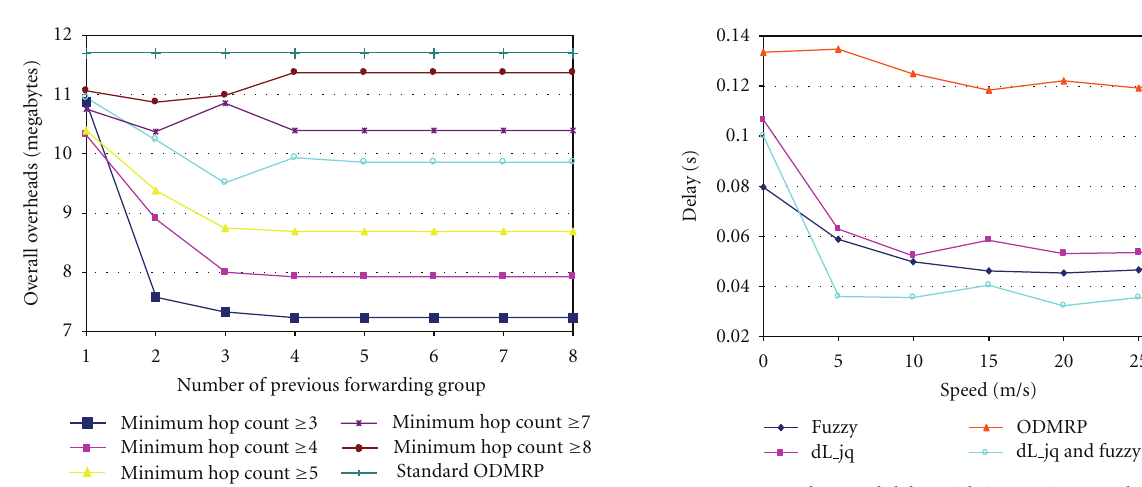
Figure 8: End-to-end delay with increasing speed of nodes.